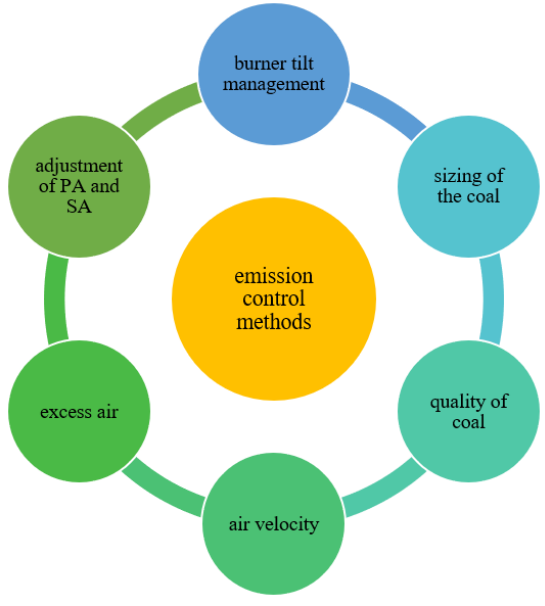
Figure 1. Emission control methods [6 – 13].